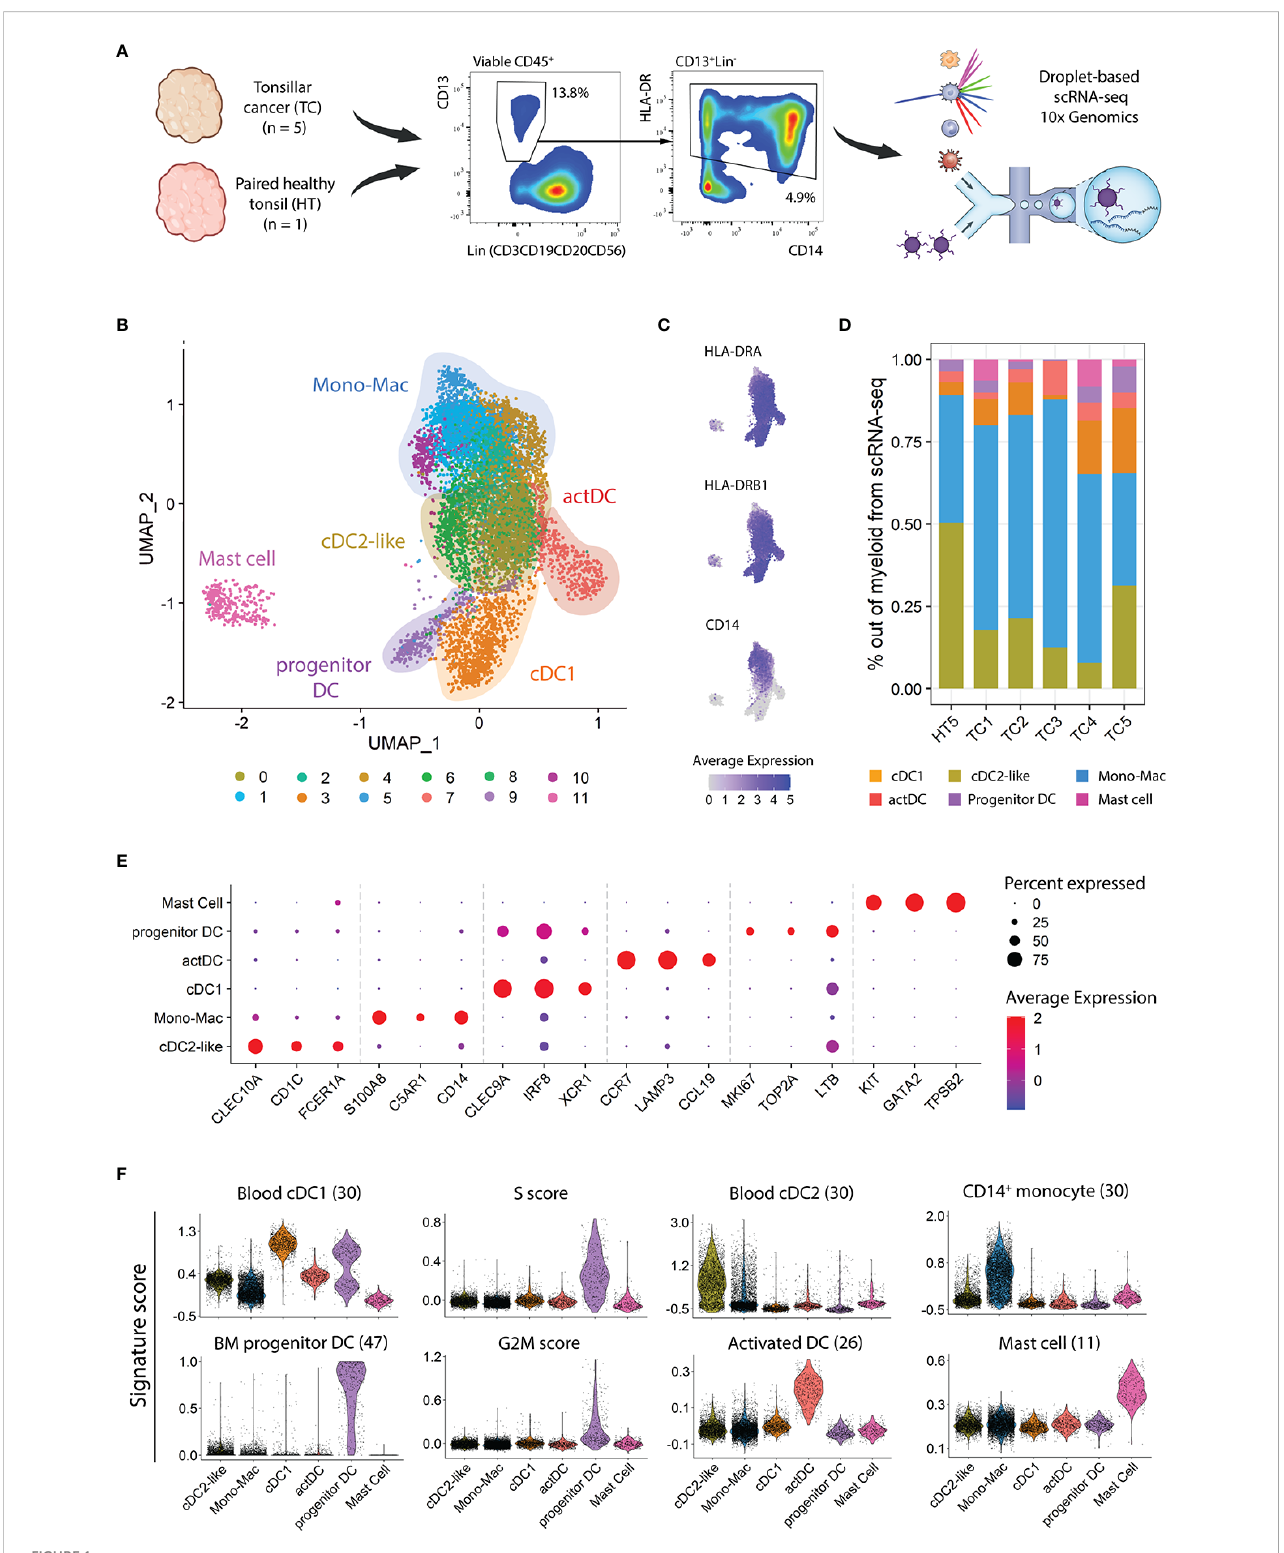
FIGURE 1 Heterogeneity of myeloid populations in TC and HT assessed by scRNAseq. (A) Viable CD45 + CD13 + HLA-DR + myeloid cells were sorted from single cell suspensions of fi ve TC samples and one contralateral HT and subjected to scRNA-seq using 10X genomics. The frequencies in the dot plots represent the average in TC calculated from viable CD45 + cells. (B) UMAP visualization of single cell transcriptomes displaying twelve clusters grouped into six major myeloid subtypes. (C) UMAP visualization, as in B, showing expression levels of HLA-DRA , HLA-DRB1 , and CD14 . (D) Frequency of myeloid populations across tissue of origin. (E) Dot plot displaying three canonical markers among the top ten differentially expressed genes across clusters. (F) Violin plots showing scores of indicated signatures. The score in each cell is shown in relative units, along with the density distribution shown by the shape of the plot. G2M and S scores represent the relative expression of cell cycle phase genes in a cell. Scale bars represent normalized counts in (C) and (E)